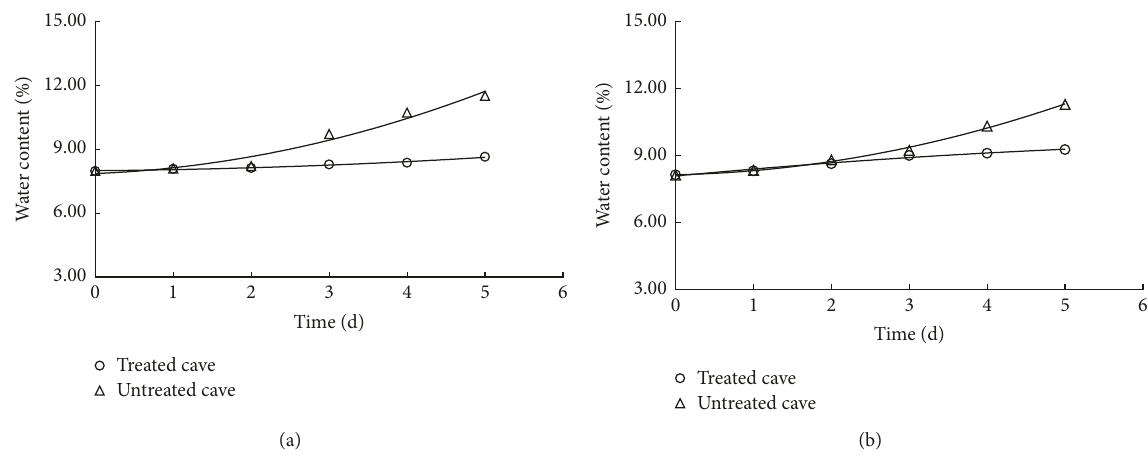
Figure 9: Moisture content changing with time: (a) model 1 and (b) model